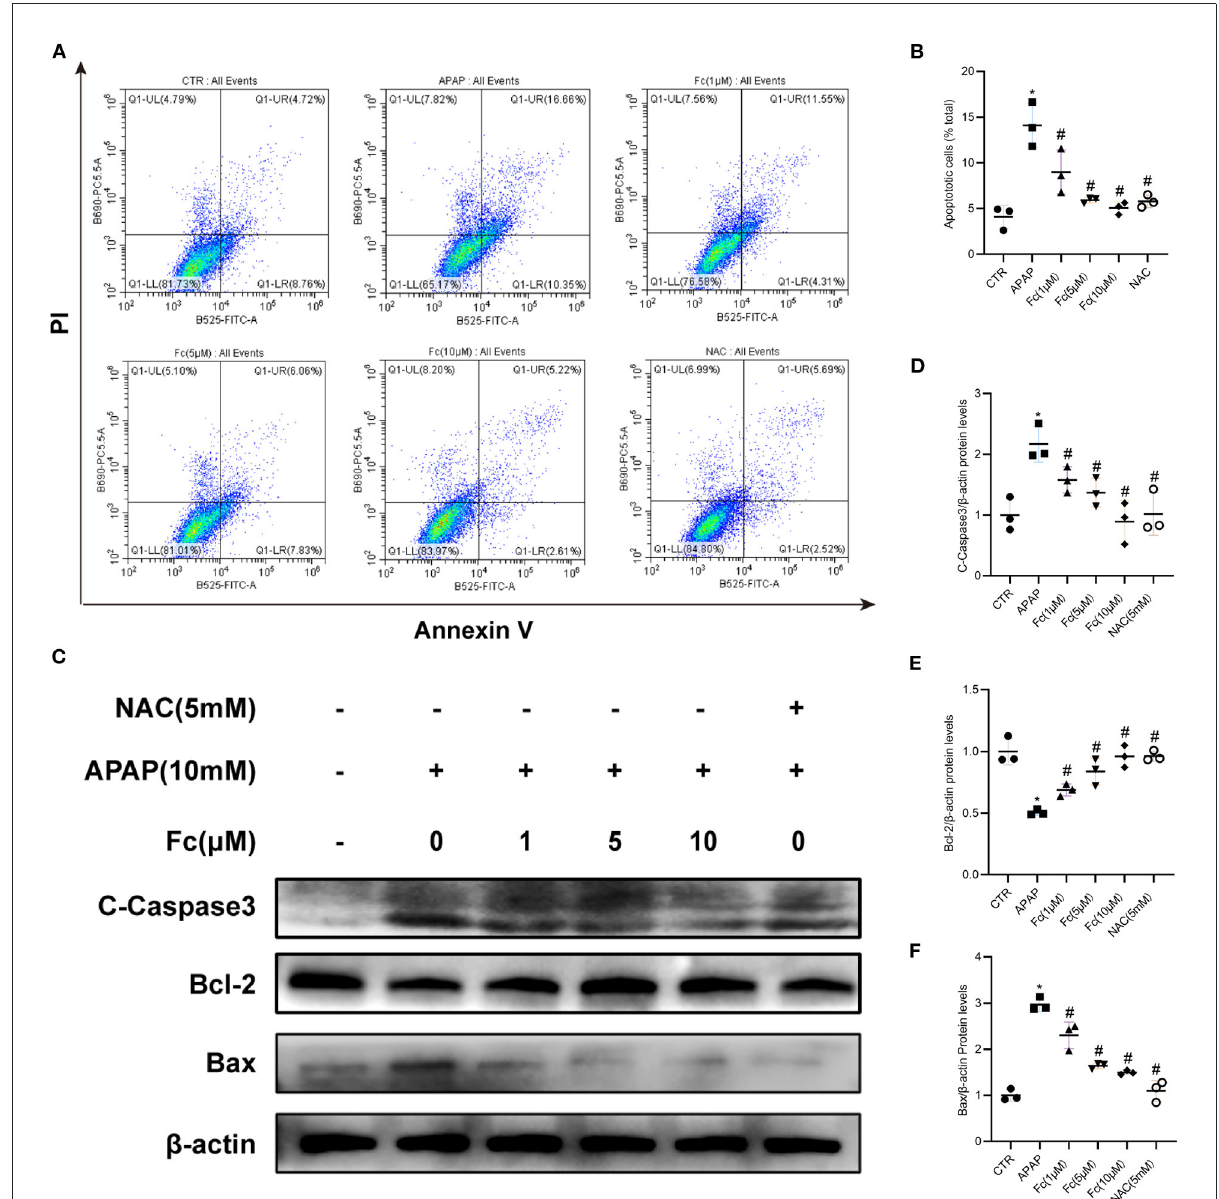
FIGURE5 Notoginsenoside Fc reduced the apoptosis of HK-2 cells under APAP exposure. (A,B) Representative images of flow cytometry and quantitative analysis of apoptosis rate in HK-2 cells. n = 3. (C–F) Representative images of Bcl-2, Bax and C-Caspase3 protein expression and semiquantitative analyses in different groups. Results were expressed as mean ± SD. * P < 0.05 vs control group. # P < 0.05 vs. APAP